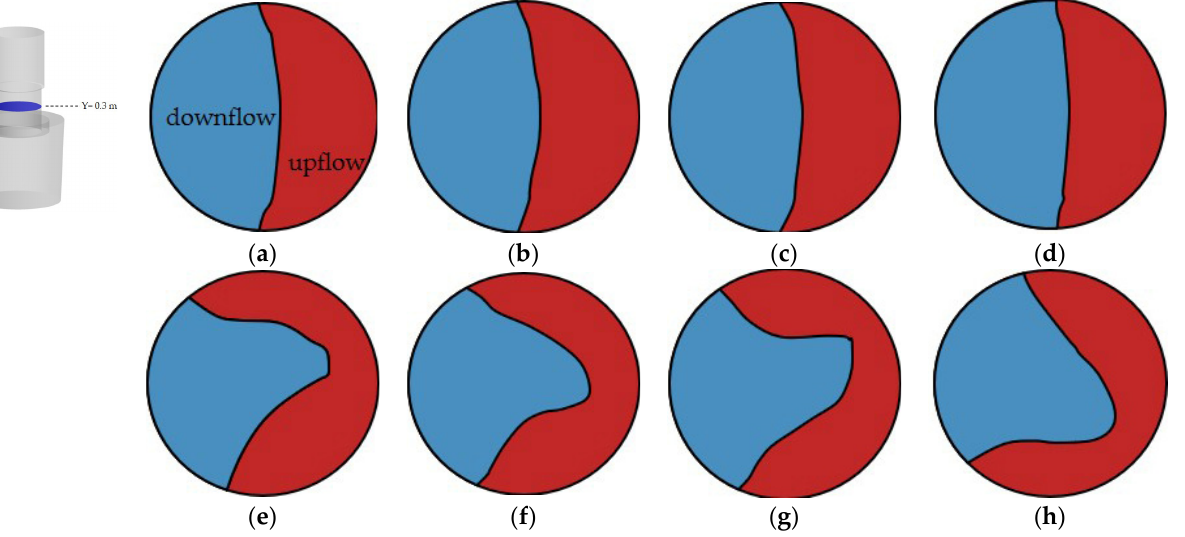
Figure 5. Area distribution of downward flow and upward flow in the Y = 0.3 plane at different flow rates and different models: ( a – d ) With PBM; ( e – h ) Without PBM; ( a , e ) 360 NL/h; ( b , f ) 720 NL/h; ( c , g ) 900 NL/h; ( d , h ) 1080 NL/h.